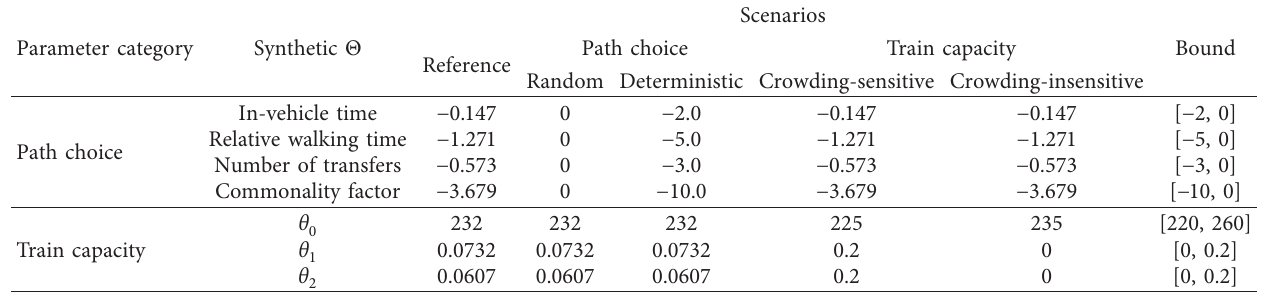
Table 2: Scenario design.